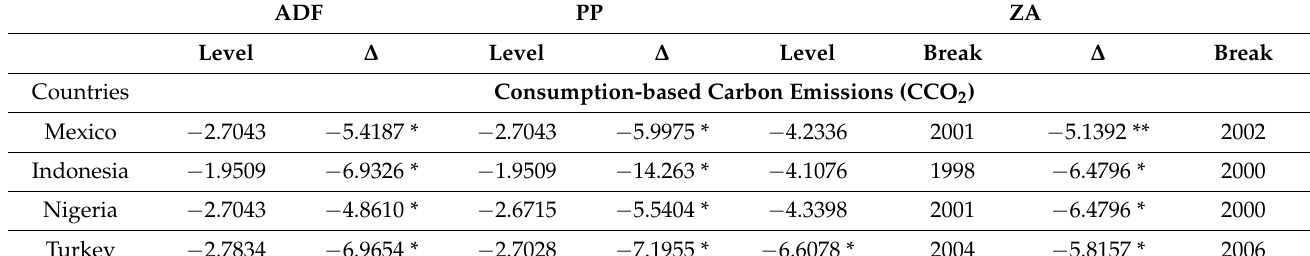
Table 3. ADF, PP and ZA Unit root